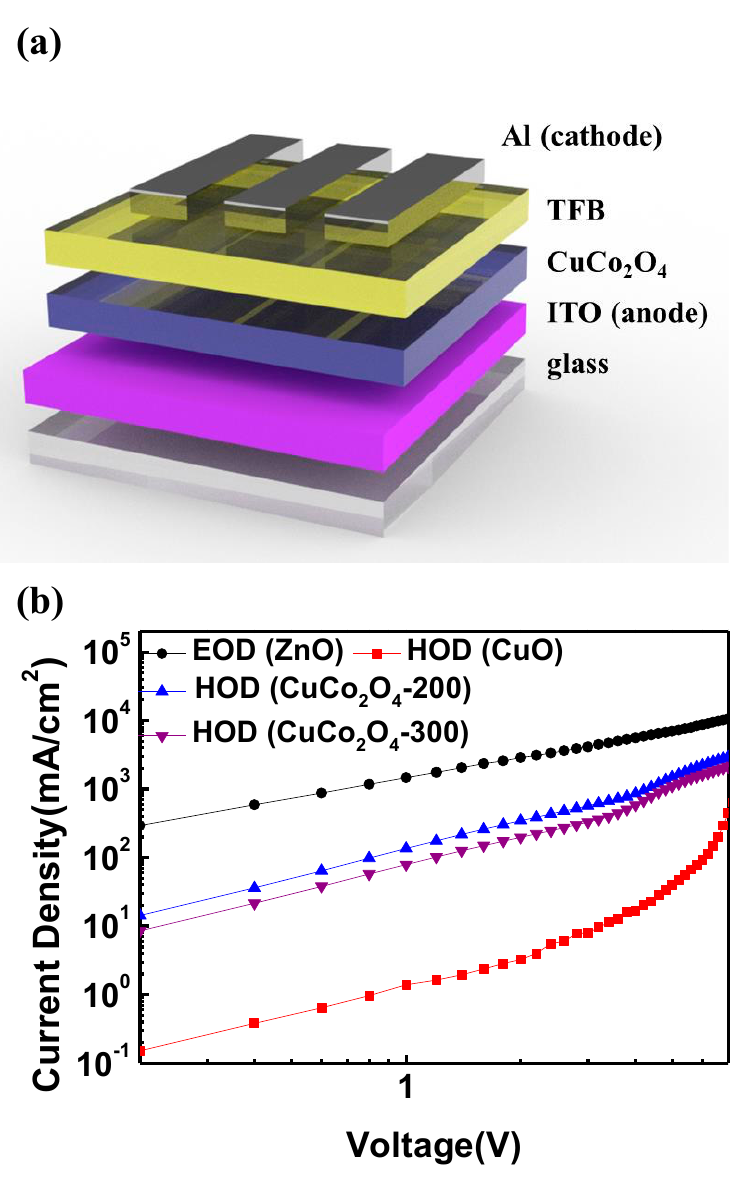
Figure 5. ( a ) Schematic structure of HOD with a CuCo 2 O 4 HIL and ( b ) current density-voltage (J-V) characteristics of HODs and the EOD.